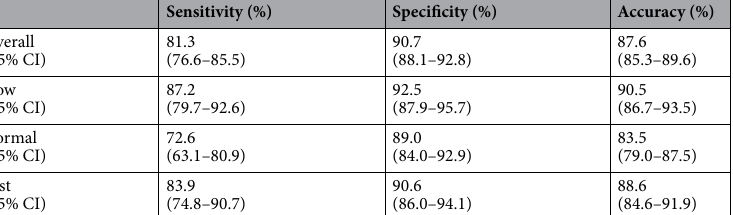
Sensitivity (%) Specificity (%) Accuracy (%)